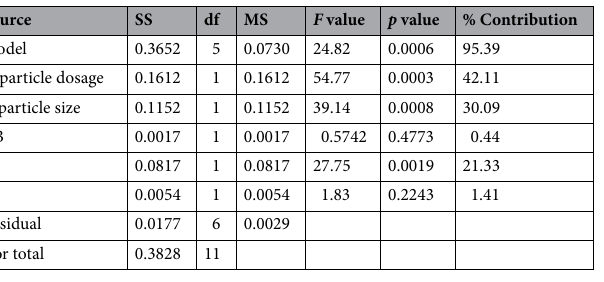
Table 6. ANOVA result on flexural modulus (FM). SS sum of squares, MS mean square.